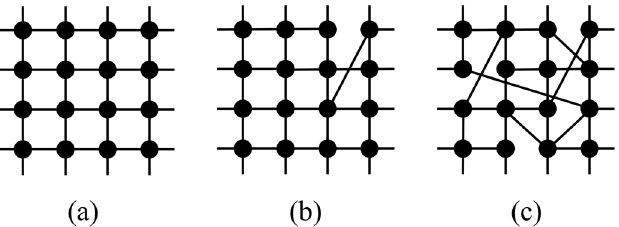
Figure 1. Illustration of the rewiring prescription for the construction of small-world networks. The network starts as a regular lattice shown in ( a ). One obtains ( b ) after the random rewiring of the first link. In ( c ) we illustrate the final result once the rewiring scheme is